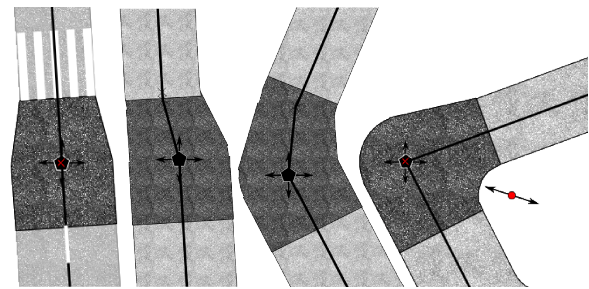
Figure 9: Variable buffer for robust roadway width transition. between vertices. One easy, but inefficient solution to compute it is to build circles and isosceles trapezoids and then union the surface of these primitives.